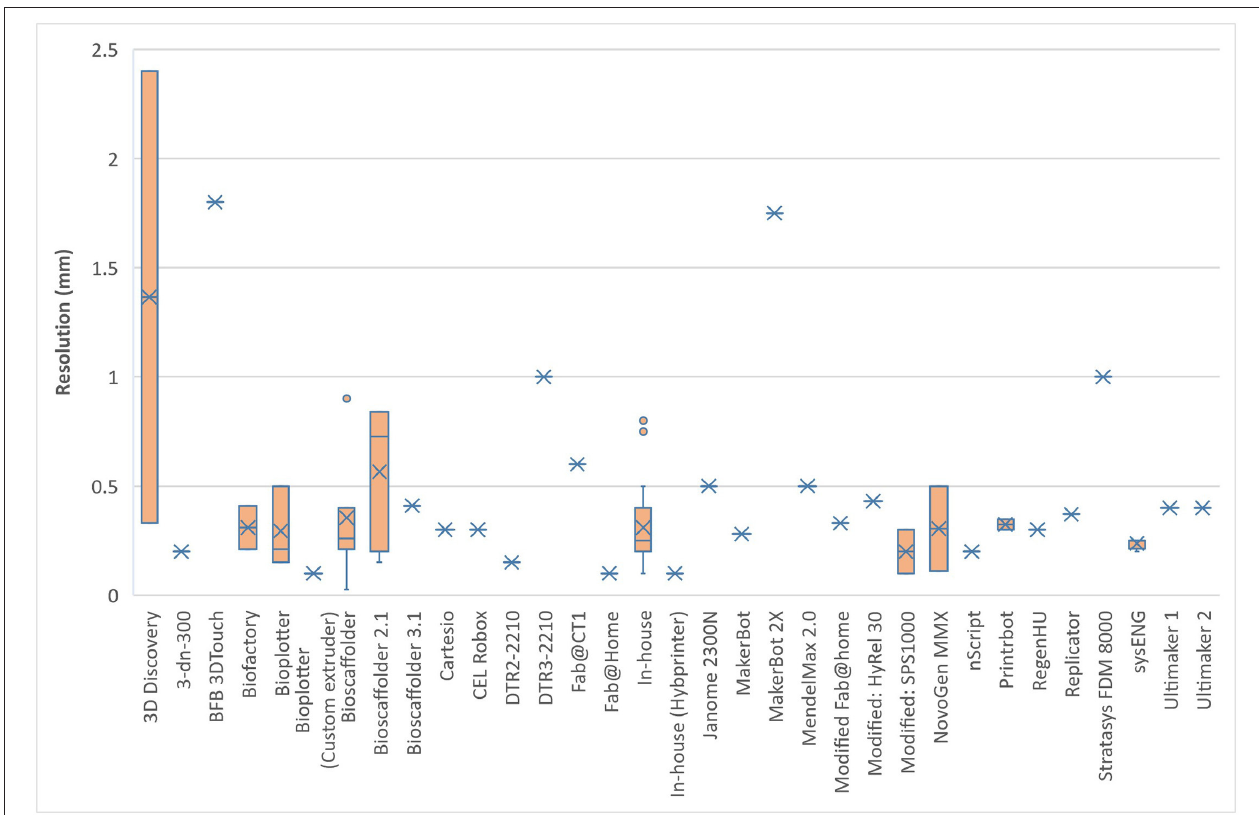
FIGURE 8 | Bioprinting resolution for different models of commercial